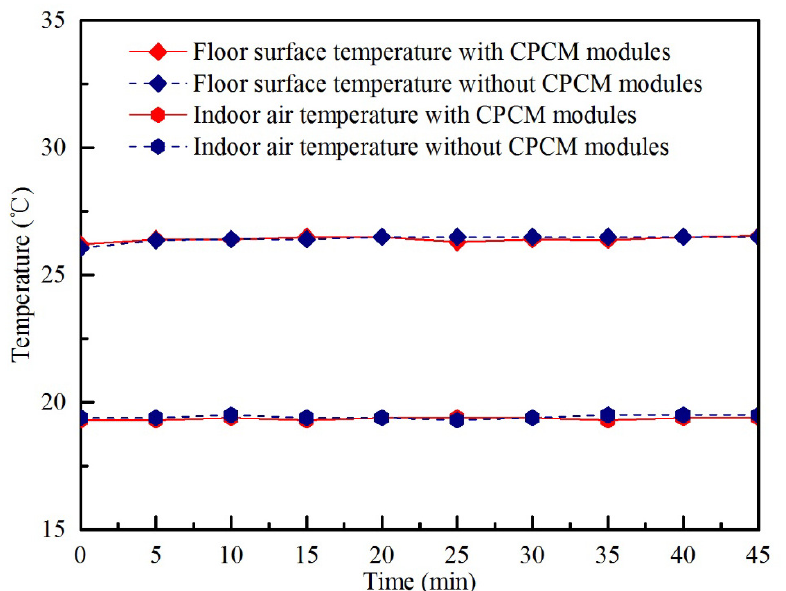
Figure 8. Temperature variations of radiant floor surface and indoor air with and without CPCM modules in the steady state of heating condition.